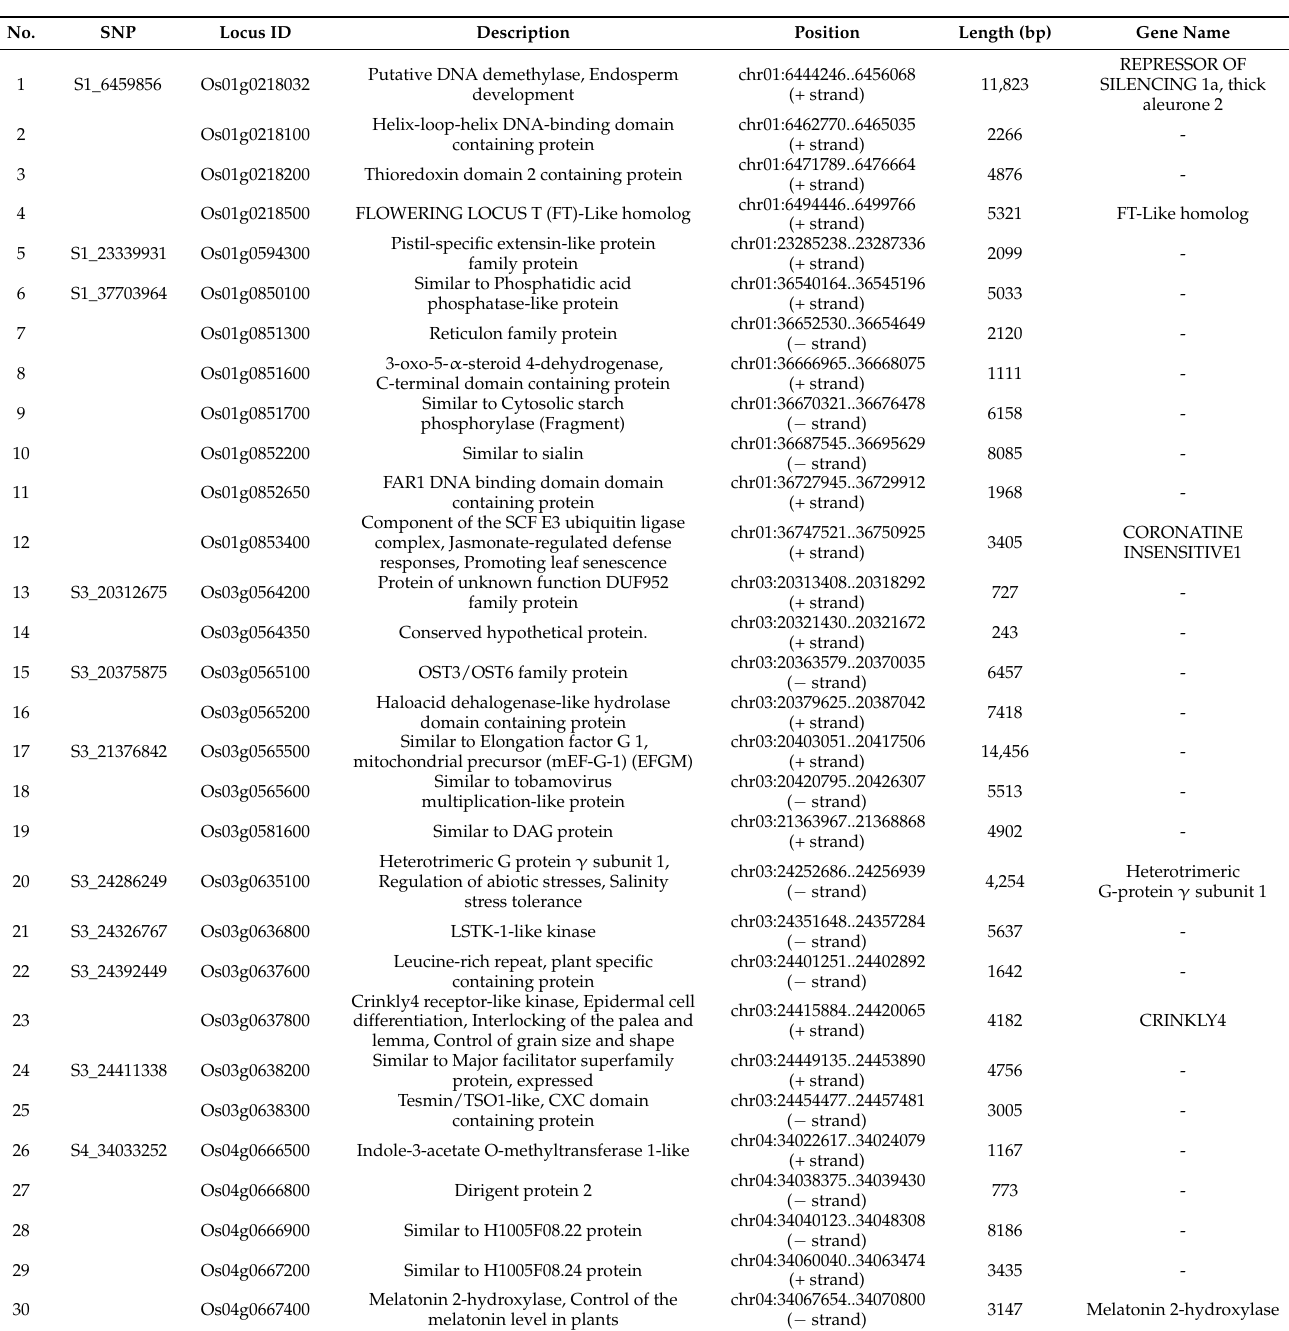
Table 3. Information of genes identified in the genomic regions detected through the GWAS on the thickness of the seed coat and aleurone